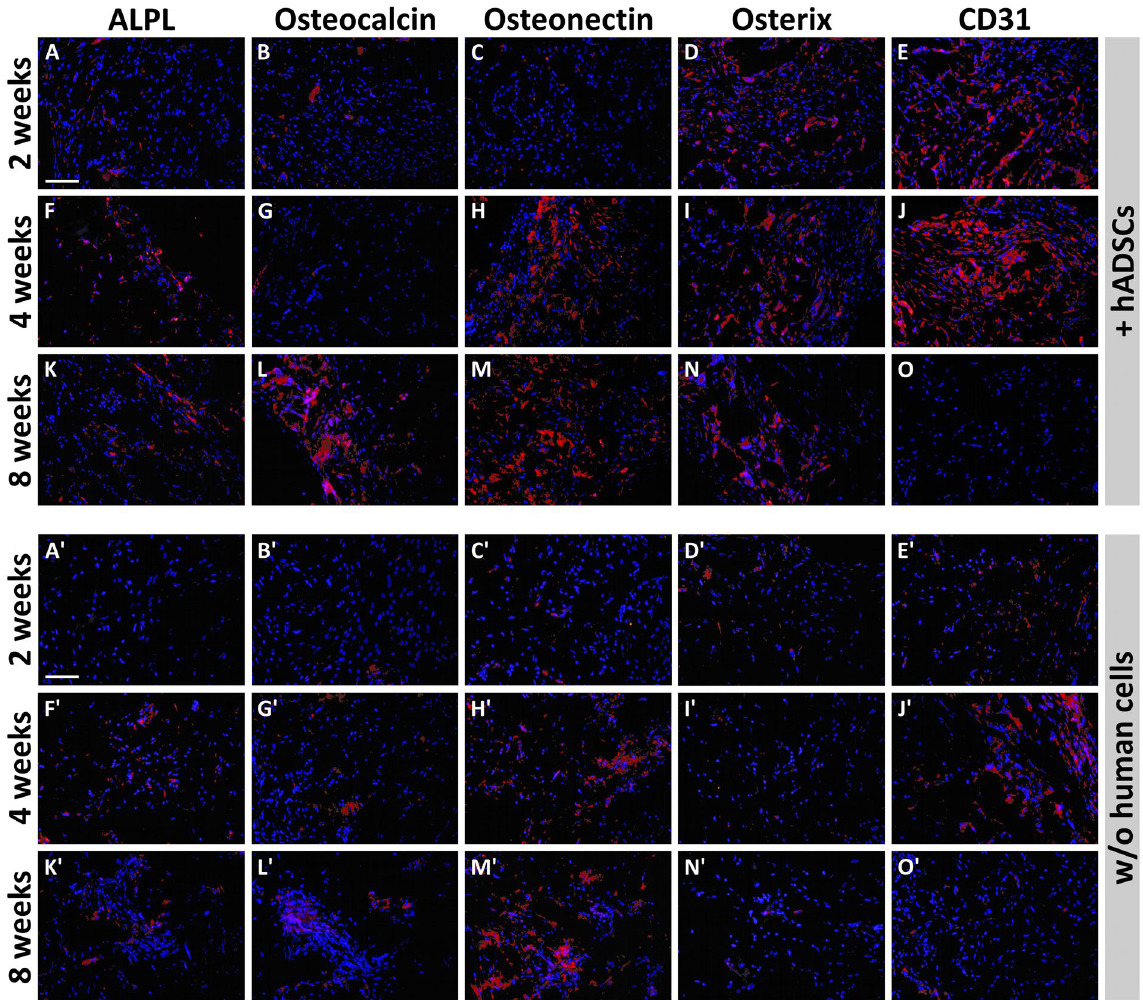
of some osteogenic markers in scaffolds plus hADSCs, especially ALPL ( A , F , K ), Osteocalcin ( B , G , L ) and Osteonectin ( C , H , M ) is increasing with time, whereas the expression of Osterix was constant along time-points ( D , I , N ) and CD31 appeared higher at 2-4 weeks post-implantation ( E , J ) and then decreased at the longer time- point ( O ). A similar pattern of time-course expression appears in scaffolds without human cells. In particular, the expression of ALPL ( A’ , F’ , K’ ) and Osteonectin ( C’ , H’ , M’ ) is increasing with time, whereas the expression of CD31 appeared higher at 2-4 weeks post-implantation ( E’ , J’ ) and then decreased at the longer time-point ( O’